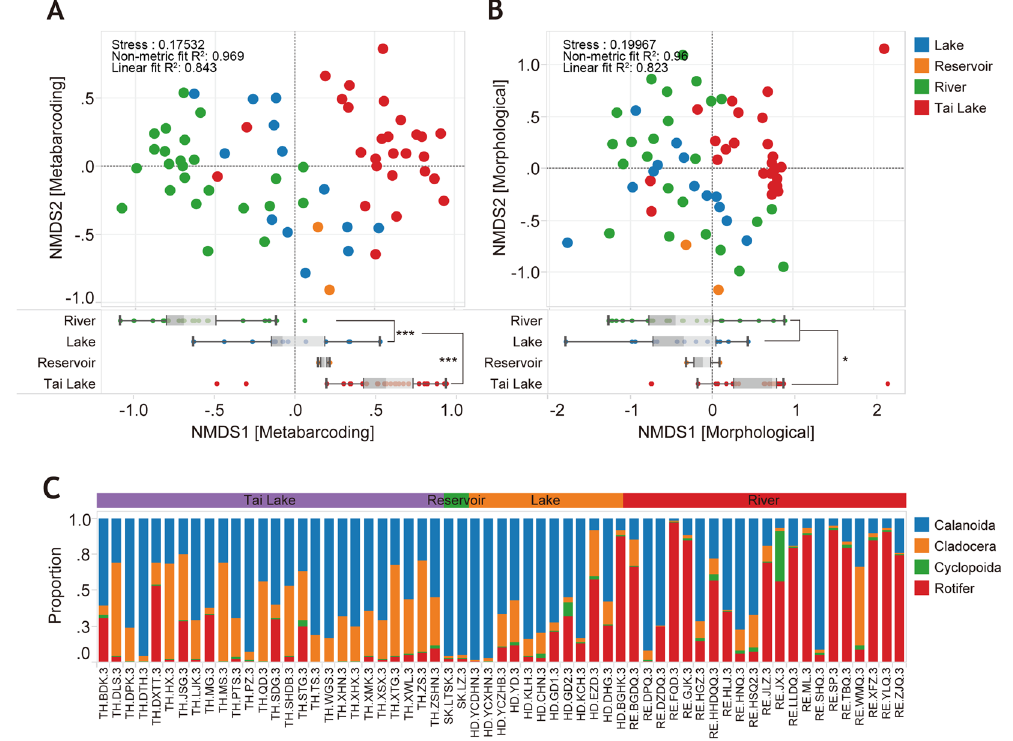
Figure 5. Composition of species and diversity of various types of aquatic environments (Tai Lake, Reservoir, River and Lake. Here, “Lake” means all the relative small lakes around Tai Lake). ( A ) Non-metric multidimensional scaling (NMDS) of zooplankton community components based on CO1 OTUs. ( B ) NMDS analysis of zooplankton community components based on morphological data. The boxplot below the NMDS illustrates the differences of NMDS1 between types of aquatic environments. Significance of ANOVA with Duncan’s post hoc tests was determined at P values < 0.001 ( *** ) and < 0.05 ( * ). ( C ) Proportions of rotifer, calanoida, cyclopoida and cladocera (based on metabarcoding data) in each